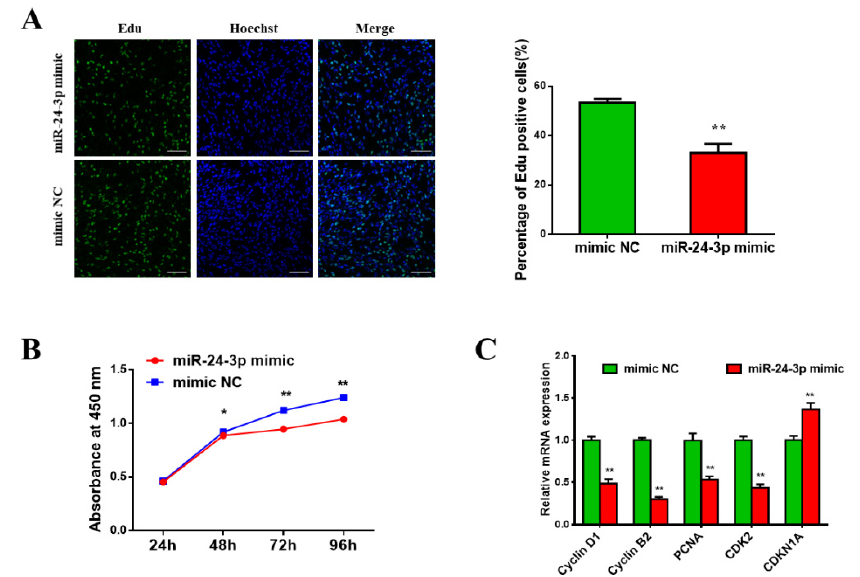
Figure 3. The effect of miR-24-3p on bovine PDGFR α - progenitor cell proliferation. ( A ) EdU staining of the PDGFR α - progenitor cells after the transfection of miR-24-3p mimics and EdU-positive cell determination. ( B ) Cell Counting Kit-8 (CCK8) assay showing that miR-24-3p mimics inhibit PDGFR α - progenitor cell proliferation. ( C ) The relative transcript levels of cell cycle-related genes after transfection. Scale bars = 100 µ m. All data are represented as mean ± standard deviation (SD), based on at least three independent experiments for each treatment. * p < 0.05 and ** p <